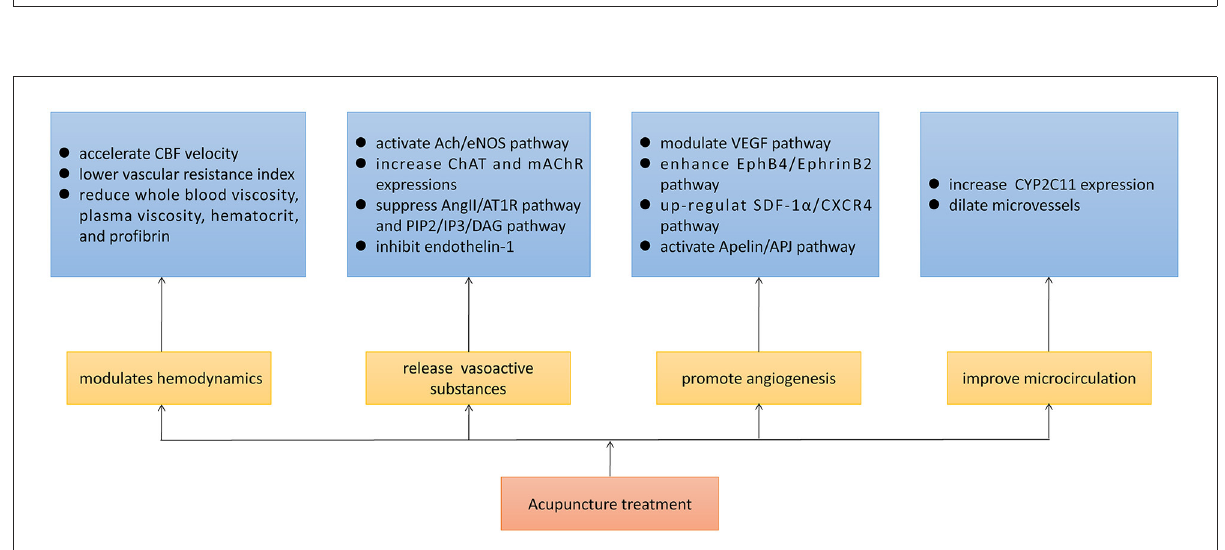
FIGURE6 Potential mechanisms of acupuncture in enhancing cerebral perfusion of ischemic